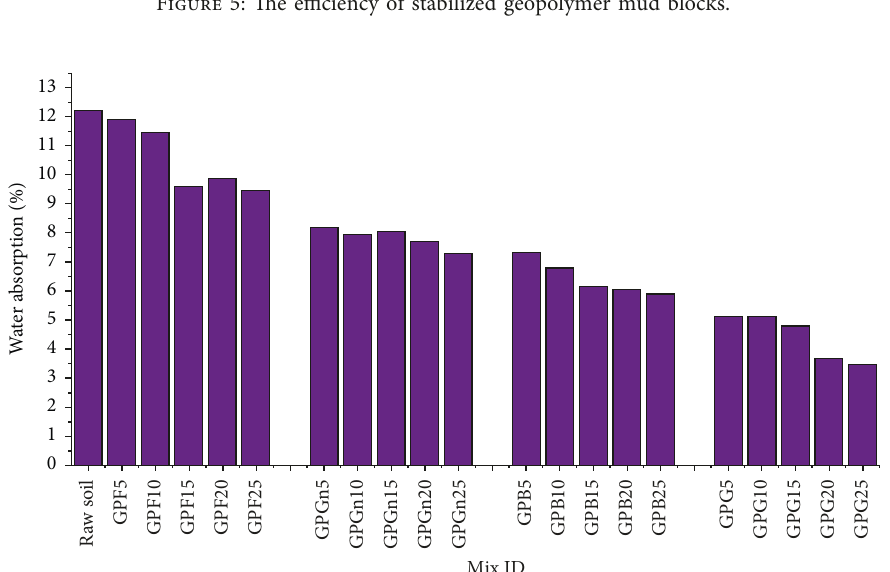
Figure 5: The efficiency of stabilized geopolymer mud blocks.